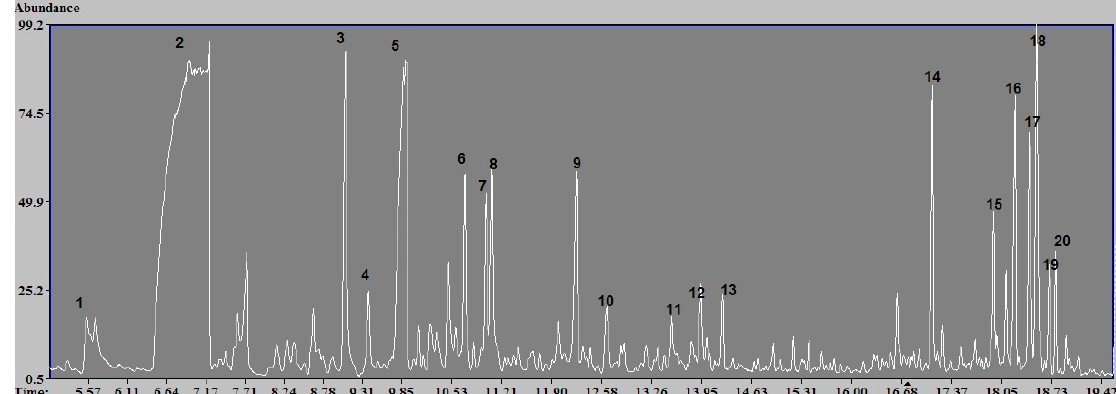
Figure 2. Chromatogram of the components selected by the SPME method. Identified components: (1) Hexanal, (2) furfural, (3) α -Pinene, (4) Camphene, (5) methylfuraldehyde, (6) 3-carene, (7) p -cymene, (8) D-limonene, (9) o-Guaiacol, (10) levoglucosenone, (11) Borneol, (12) Creosol, (13) Berbenone, (14) Longifoline, (15) γ -Muurolene, (16) α -Muurolene, (17) γ -Cadinene, (18) δ -Cadinene, (19) α -Cadinene, and (20) α -Calacorene.